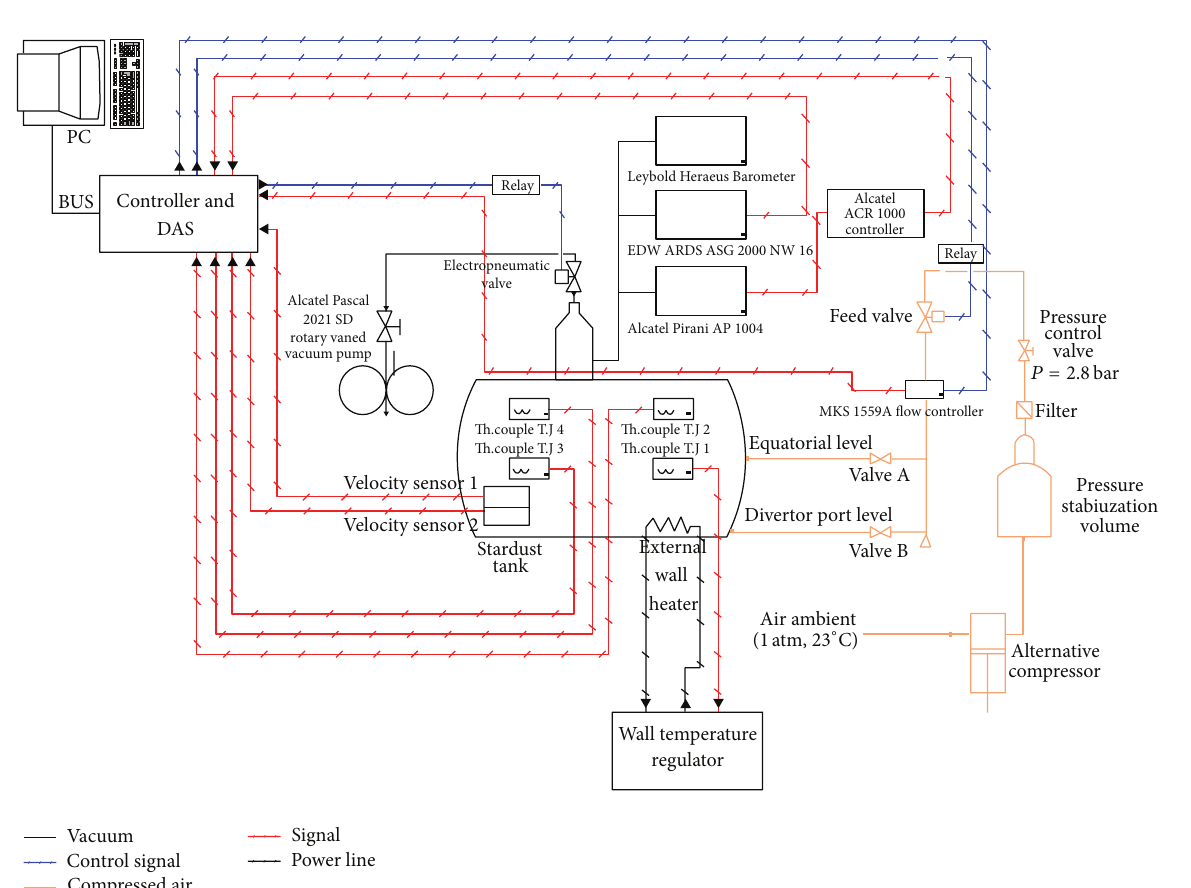
Figure 7: STARDUST functional scheme for